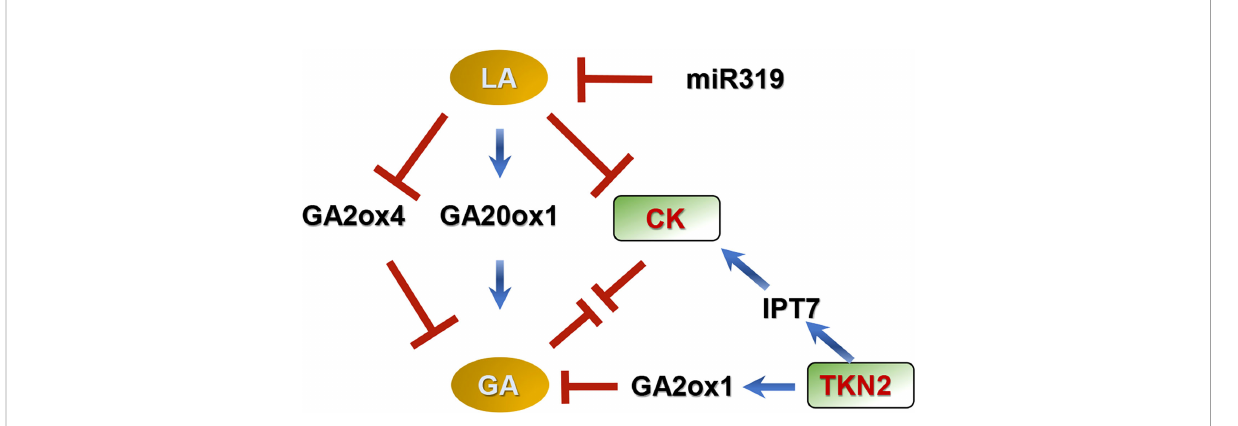
FIGURE 2 Model for compound leaf development regulated by GAs in tomato (Jasinski et al., 2005; Bolduc and Hake, 2009; Israeli et al., 2021). In this model, GAs promote differentiation and delay morphogenesis, decreasing leaf complexity, while CKs promote morphogenesis and delay differentiation, increasing lea fl et number in tomato. GAs interact antagonistically with CKs during early lea fl et origination. LANCEOLATE (LA) and TKN2 (a Class I KNOTTED1-LIKE HOMEOBOX protein) coordinate the balance between GAs and CKs during leaf development. LA is negatively regulated by MicroRNA319 (miR319). LA increases GA concentration by up-regulating GA20ox1 and down-regulating GA2ox4 , meanwhile this protein decreases CK concentration. TKN2 increases CK concentration by stimulating expression of ISOPENTENYL TRANSFERASE 7 (a CK biosynthetic gene), and reduces GA concentration by motivating GA2ox1 (a GA deactivated gene) expression. ↓ represents positive regulation. ⊥ represents negative